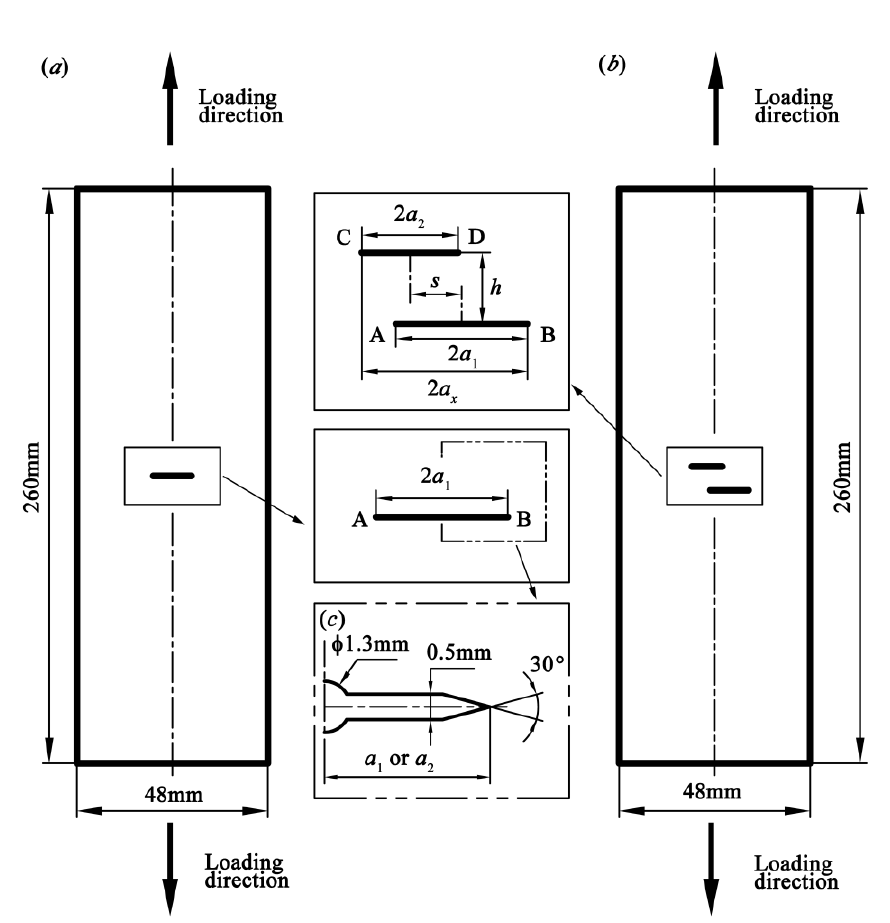
Table 3. Initial sizes and positions of the cracks in seven groups of specimens.